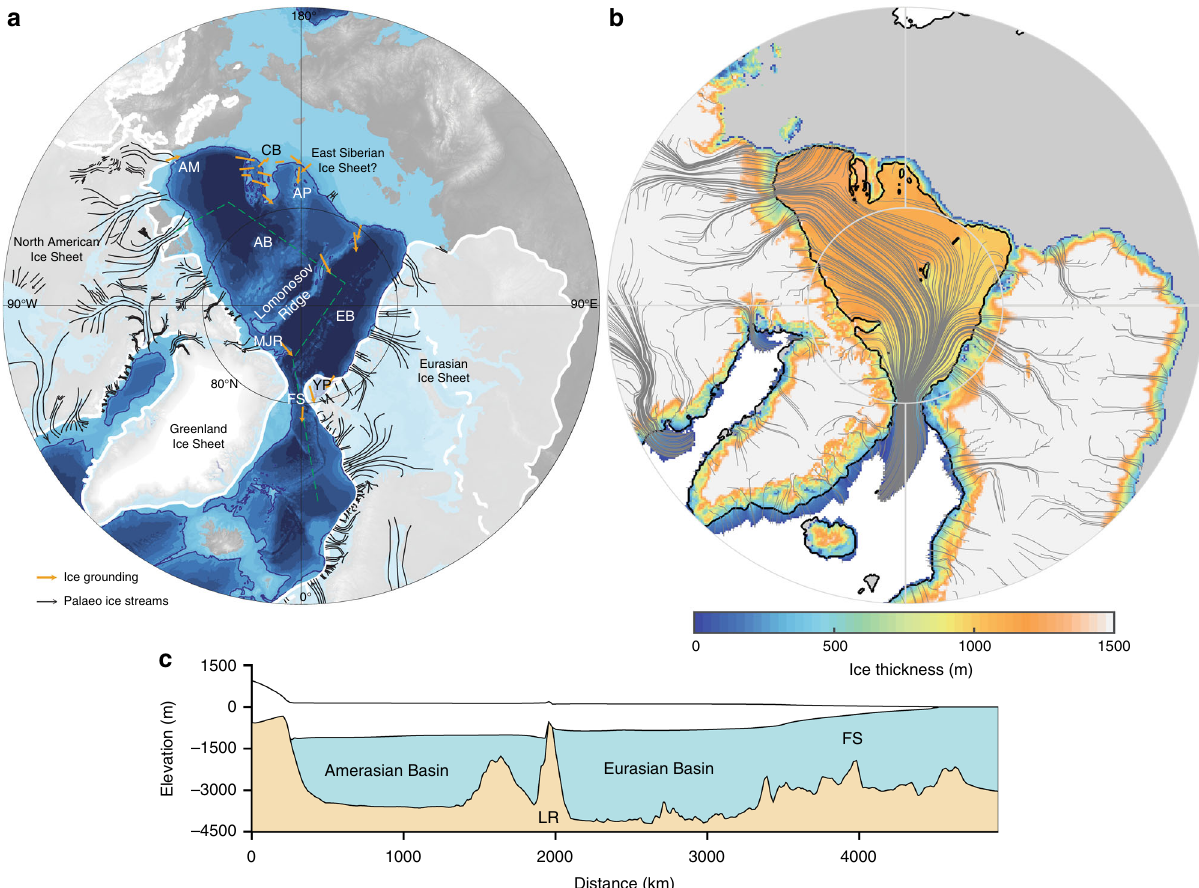
Fig. 1 Ice shelf grounding from observations and model output. a Summary of location and inferred fl ow directions of bathymetric ice grounding features from previous publications 10,12,55 – 57 (orange lines and arrows). White lines shown extent of Eurasian Ice Sheet during MIS6 35 (solid line) and the LGM 30 (dashed line), and for North America at the LGM 29 (solid line). Black lines show location and fl ow direction of marine-terminating palaeo ice streams, for North America 58 and mapped for Eurasia using the same methodology as ref. 58 , also shown is the recently discovered De Long Trough in Eastern Siberia 28 . Dashed green line is the transect shown ( c ) and dark blue line shows the 1000 m bathymetric contour. b Ice sheet model output showing ice thickness and streamlines, black lines show the grounding line and coastline, note areas of ice grounding on the Lomonosov Ridge, Arlis Plateau and Morris Jessup Rise. Grey shading shows land above sea level. c Ice sheet model output showing transect across Amerasian and Eurasian Basins and through the Fram Strait. Locations referred to in the text: AM Alaskan Margin, CB Chucki Borderland, AP Arlis Plateau, AB Amerasian Basin, LR Lomonosov Ridge,